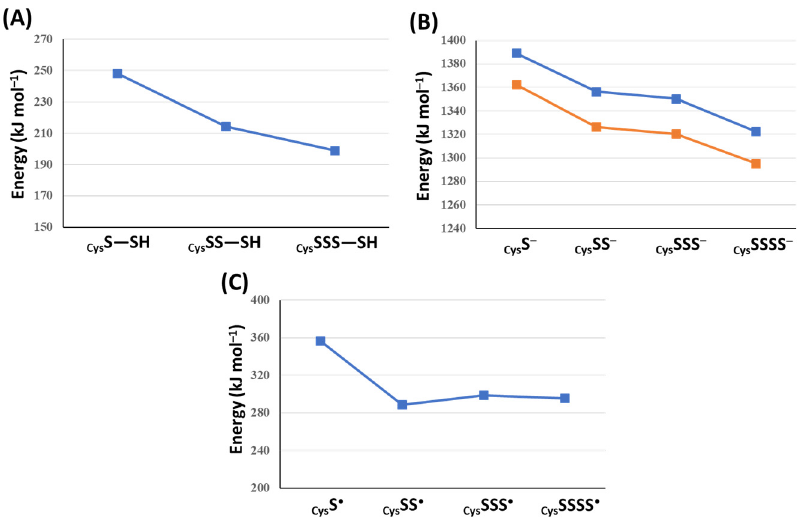
Figure 2. Calculated (at the ω B97XD/6-311G(2d,p) level of theory) values of ( A ) RS n —SH BDEs for Cys SS n H ( n = 1–3), ( B ) PAs (blue) and GPBs (orange) of Cys SS n − ( n = 0–3), and ( C ) HAs of Cys SS n • ( n = 0–3). All energies are in kJ mol − 1 .